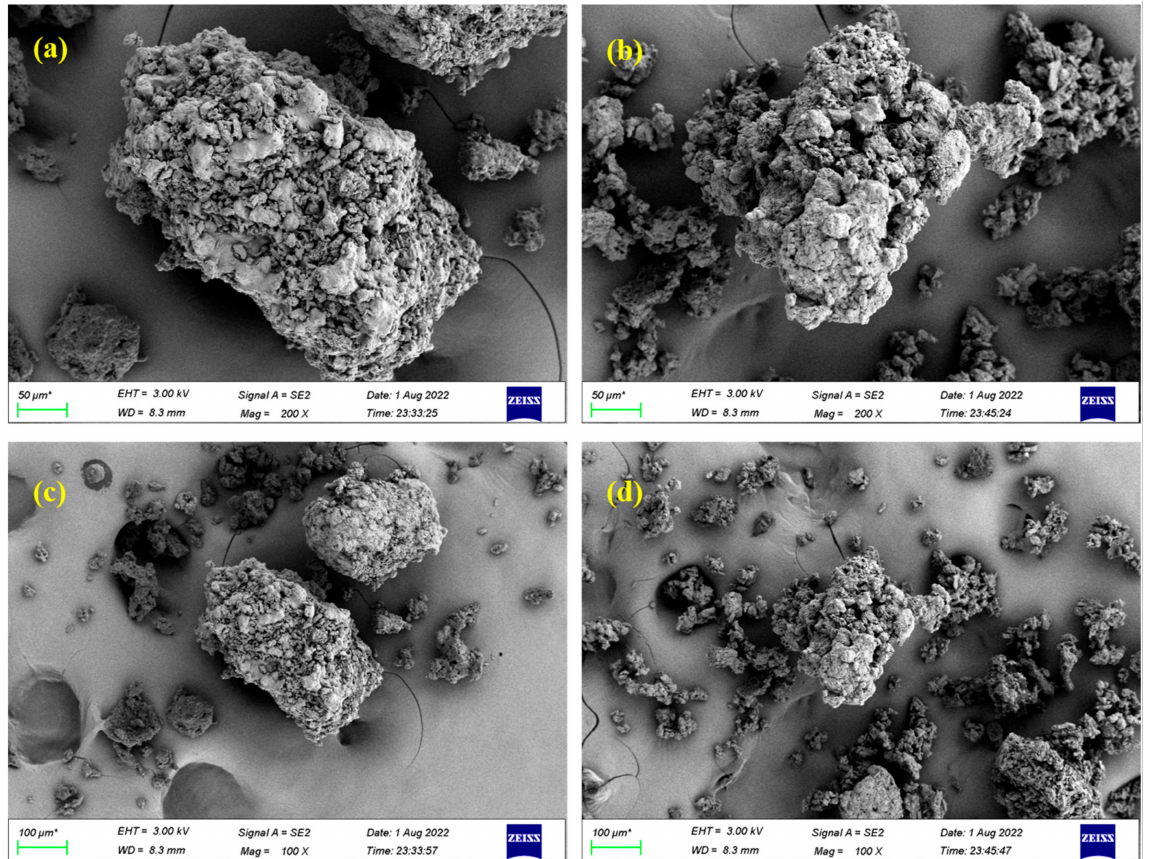
Figure 4. SEM of NaAlO 2 ( a , c ) before reaction, ( b , d ) after reaction (* is only used as a magnification mark, no special significance).